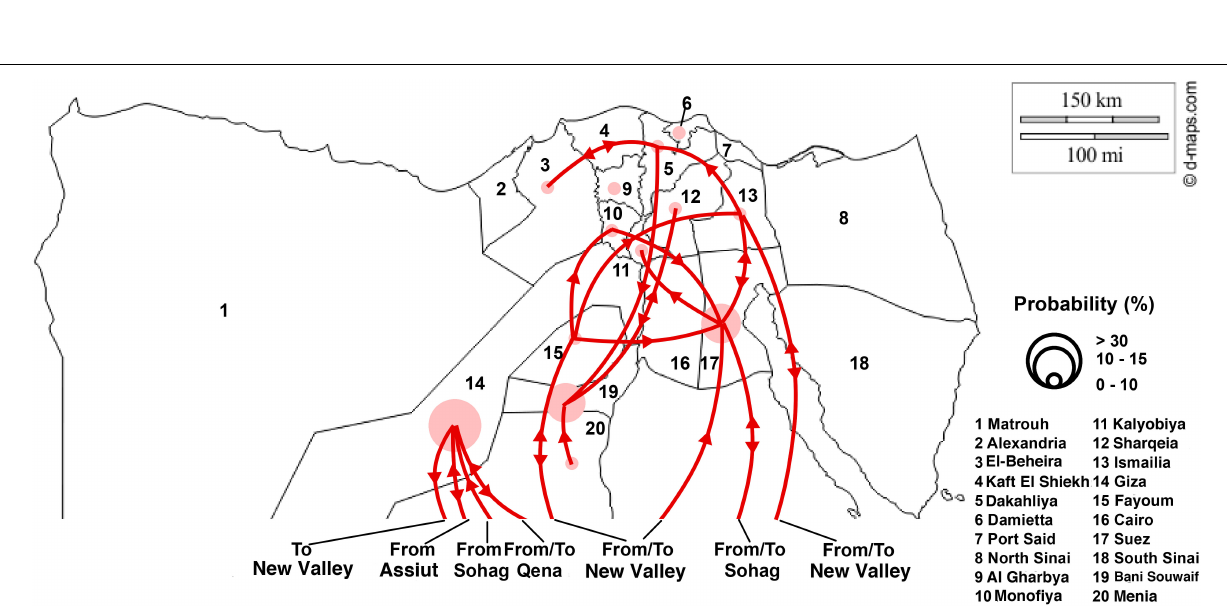
Frontiers in Microbiology |